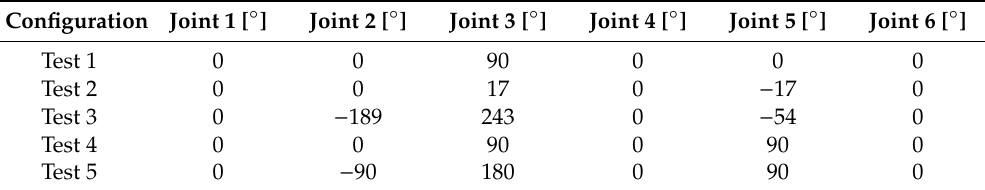
Figure 4. Robot configurations. Table 1. Robot testing